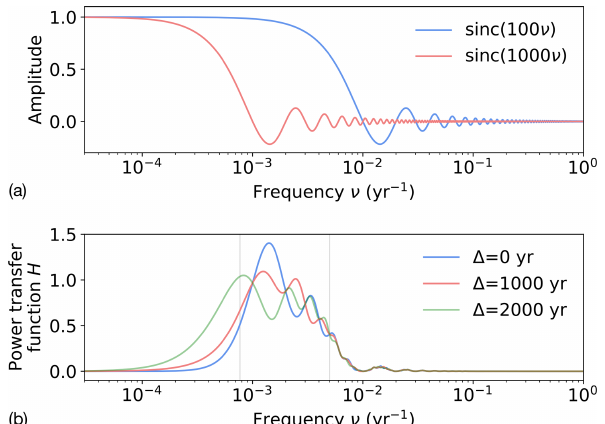
Figure 2. The power transfer function H (Eq. 3) illustrates the dependence of temporal representativeness errors on frequencies in the climate signal and on sampling timescales. In the case in which the offset (cid:49) between the measurement and target is 0, H is a squared difference of sinc functions sinc( τν ) as in Eq. (A13), illustrated in (a) for τ = 100 years and τ = 1000 years. (b) Transfer functions for three different values of the time offset (cid:49) . Grey bars indicate the 1 / 200 and 1 / 1300yr − 1 frequencies, which approxi- mately bound the frequencies contributing to TR errors in the (cid:49) = 0